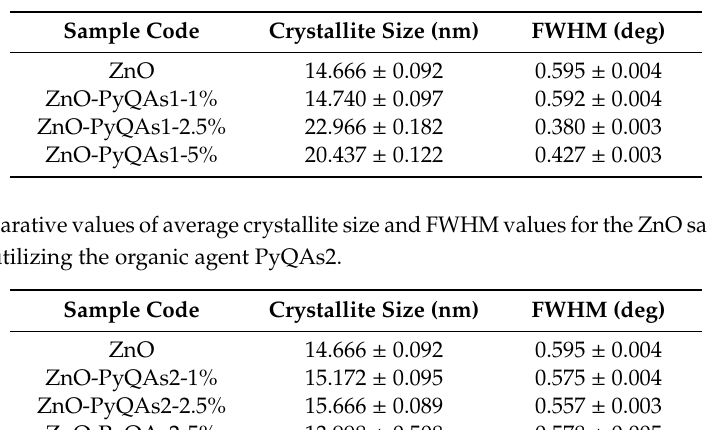
Table 1. Comparative values of average crystallite size and FWHM values for the ZnO samples obtained by the recipe utilizing the organic agent PyQAs1.